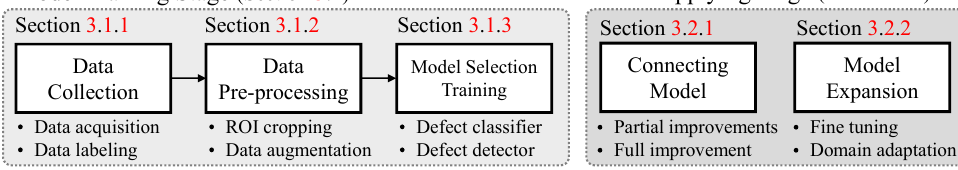
Figure 2. Deep learning model training and applying stages for a product inspection